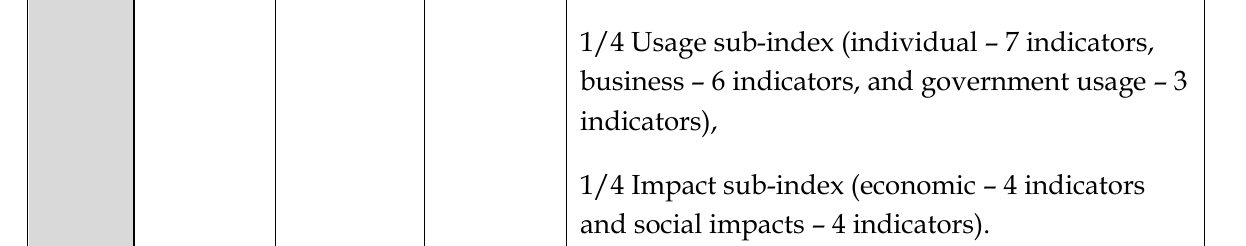
Figure 1: The progress of the EGDI between the years 2008–2014